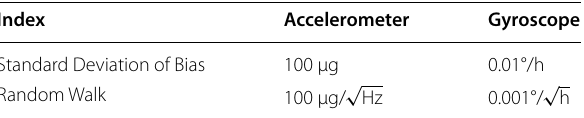
Table 1 Specification of the IMU used in the static simulation experiment